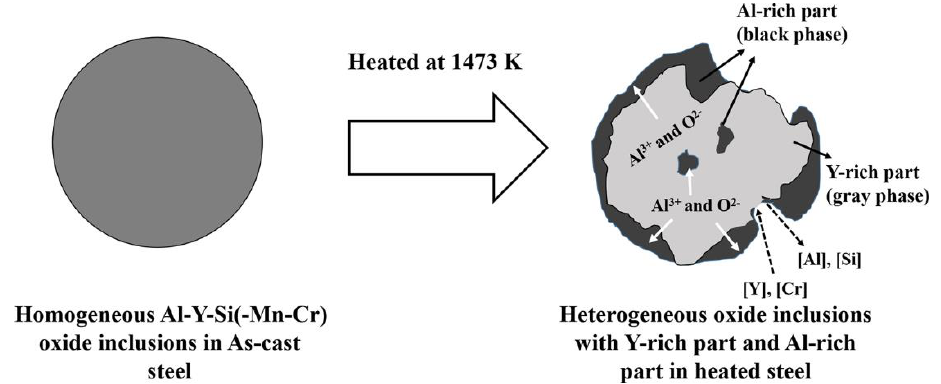
Figure 14. Schematic of the transformation mechanism of yttrium-based oxide inclusions during isothermal heating at 1473 K.